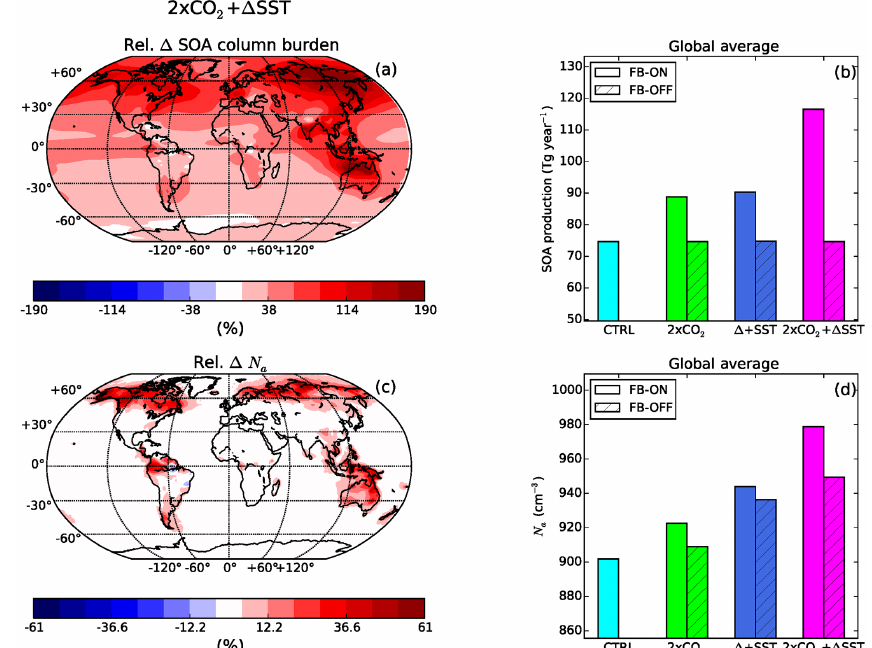
Figure 4. The relative difference between the FB-ON and FB-OFF simulations in the annual average column burden SOA (a) and N a in the boundary layer (c) for the 2 × CO 2 + (cid:49) SST experiment. In the bar plots, the average yearly global production of SOA (b) and the global average N a in the boundary layer (d) are shown for the CTRL simulation as well as the three experiments (both FB-ON and FB-OFF